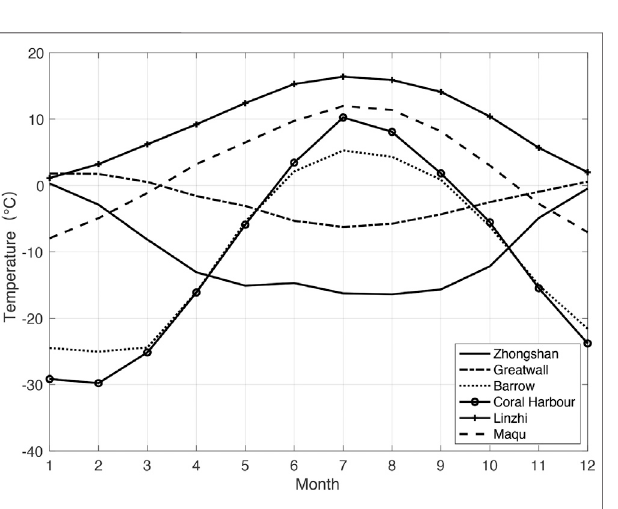
Frontiers in Earth Science |